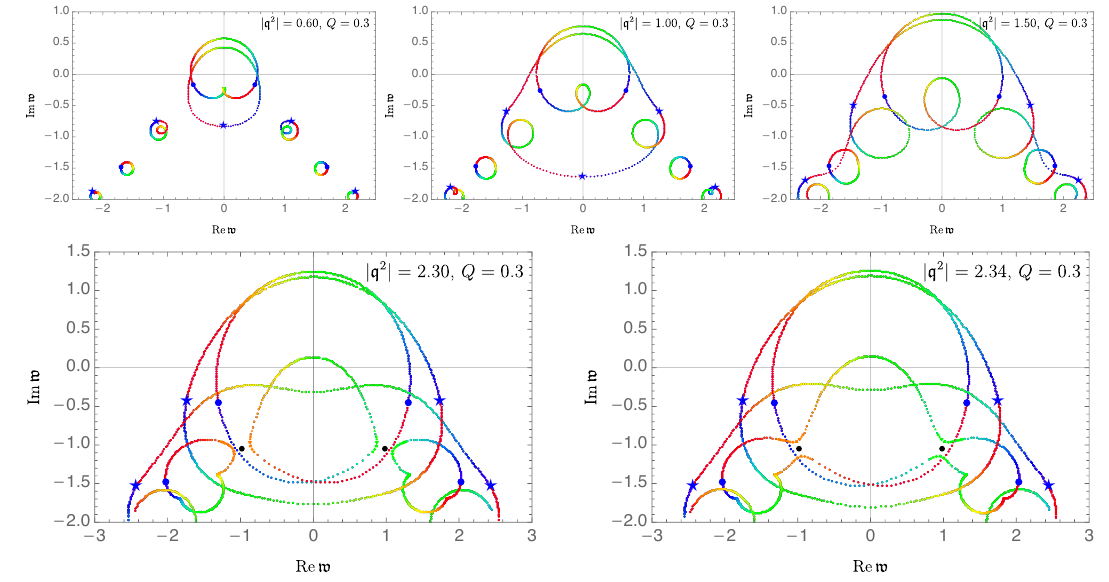
Figure 8. Poles of the retarded two-point function in the spin 0 channel at Q = 0 : 3, in the complex w (cid:0) plane, at various values of the complexi(cid:12)ed momentum q 2 = j q 2 j e i(cid:18) . Large dots and large stars correspond to the poles with purely real momentum (i.e. at (cid:18) = 0). As (cid:18) increases from 0 to 2 (cid:25) , each pole moves counter-clockwise following the trajectory whose color changes continuously from blue to red. While at j q 2 j = 0 : 60 (top left panel) all poles follow closed orbits, at j q 2 j = 1 : 00 (top middle panel), the hydrodynamic di(cid:11)usion pole and the two lowest (namely nearest to the horizontal axis) star gapped poles follow open orbits. It simply means that the dispersion relation w di(cid:11)usion ( q 2 ) has branch point singularities in the complex momentum squared plane at (0 : 60) 1 = 2 < j q c j < (1 : 00) 1 = 2 . It is clear that the point ( Q = 0 : 5 ; j q c j ) then lies on the red curve in (cid:12)gure 7. At j q 2 j = 1 : 50 (top right panel) the orbits of the hydrodynamic sound pole and the two nearest dot poles are still closed. However, by further increasing j q 2 j , their associated trajectories come close to each other. Finally they collide at the positions marked by black dots in the bottom row plots. The collision points are identi(cid:12)ed with critical value of momentum j q 2 j = 2 : 32. It is clear that the point ( Q = 0 : 3 ; (2 : 32) 1 = 2 ) c lies on the blue curve in (cid:12)gure 7. After the collision, for instance at j q 2 j = 2 : 34, the orbits